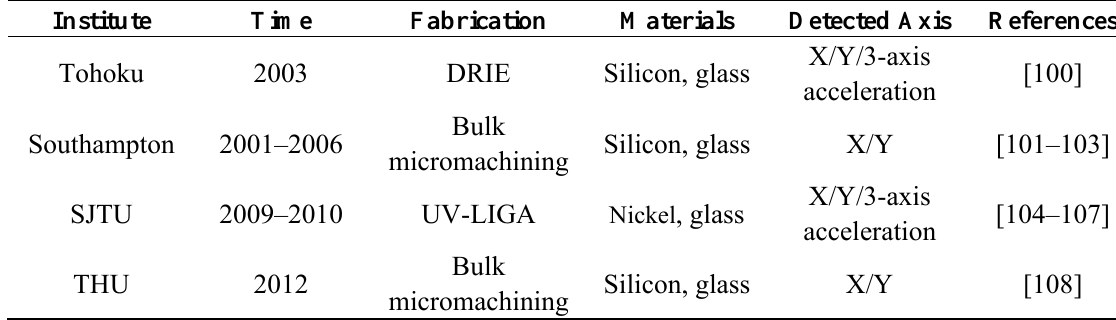
Table 9. The summary of MESG gyroscopes.